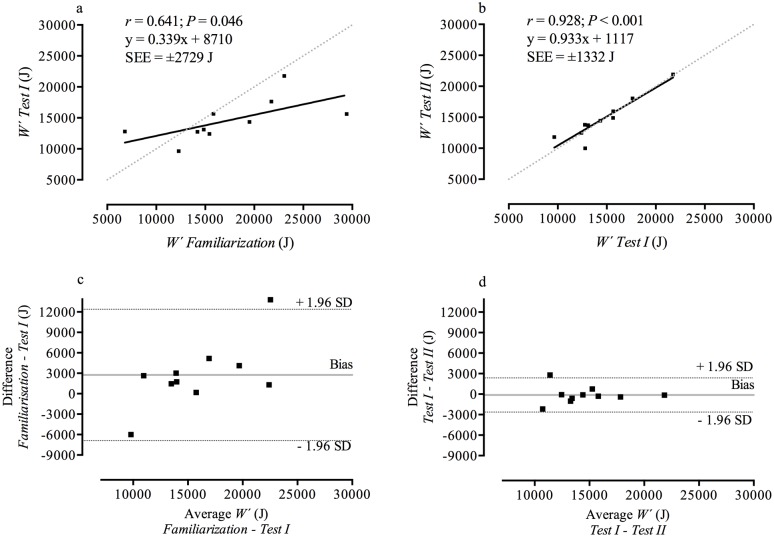
Relationships (panels a and b) and Bland-Altman plots of the differences (panels c and d) between repeated tests of W´.The black solid line represents the linear regression and the grey-dotted line represents the line of identity (panel a and b). The solid grey line represents the mean bias and the dotted black line represent the 95% limits of agreement (panel c and d).